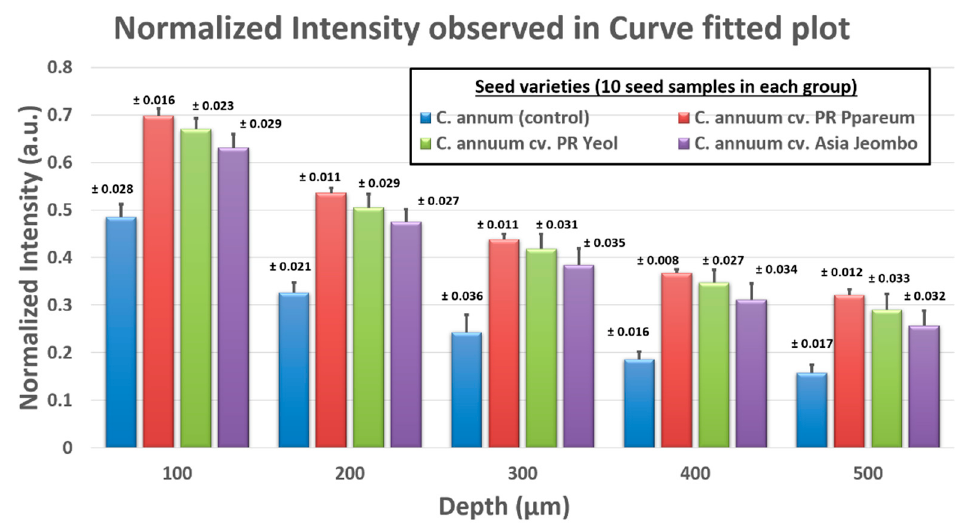
Figure 6. Graphical representation of the normalized intensities observed in curve fitted plot at different depth for all seed category groups. The detailed representation of values is shown in Table 1.